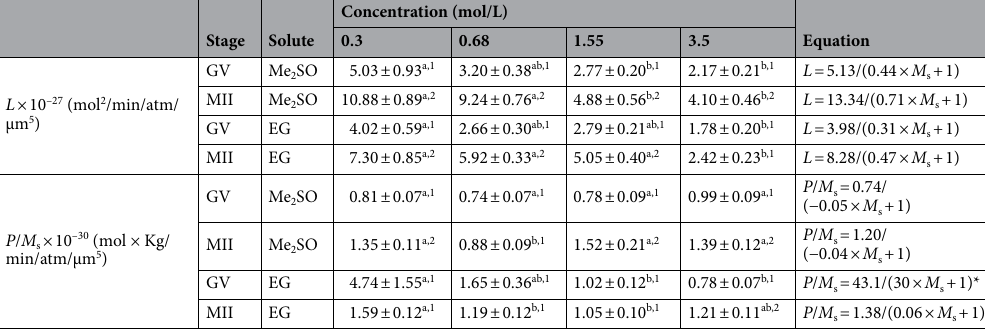
Table 2. Bovine oocyte plasma membrane water permeability ( L ), solute permeability ( P ) of immature (GV) and mature (MII) oocytes in the presence of increasing CPA (EG or Me 2 SO) concentrations. Permeability parameters obtained from 0.3, 0.68, 1.55 and 3.5 mol/L EG or Me 2 SO data fit with the nondilute model. The equation represents the best-fit model curve for each stage and CPA. Unless indicated otherwise, data are given as the mean ± s.e.m. Different superscript letters indicate significant differences between different molarities within the same CPA and nuclear stage ( P < 0.05). Different superscript numbers indicate significant differences in water or solute permeability between GV and MII stage within the same CPA ( P < 0.05). * In this case the fitting algorithm was unable to converge because the value of b was so large that the 1 in the denominator became negligible. This results in a constant ratio a / b , which can be satisfied using various combinations of a and b . The values of a and b in Table 2 were chosen arbitrarily among the possible values that match the best-fit value of a / b . GV germinal vesicle, MII metaphase II, Me 2 SO dimethyl sulfoxide, EG ethylene